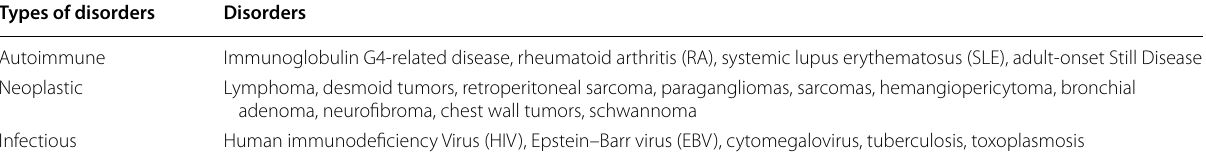
Table 2 Autoimmune, neoplastic, and infectious disorders with significant shared clinical, histologic, and immunologic features of Castleman disease (CD) [3, 4, 11,